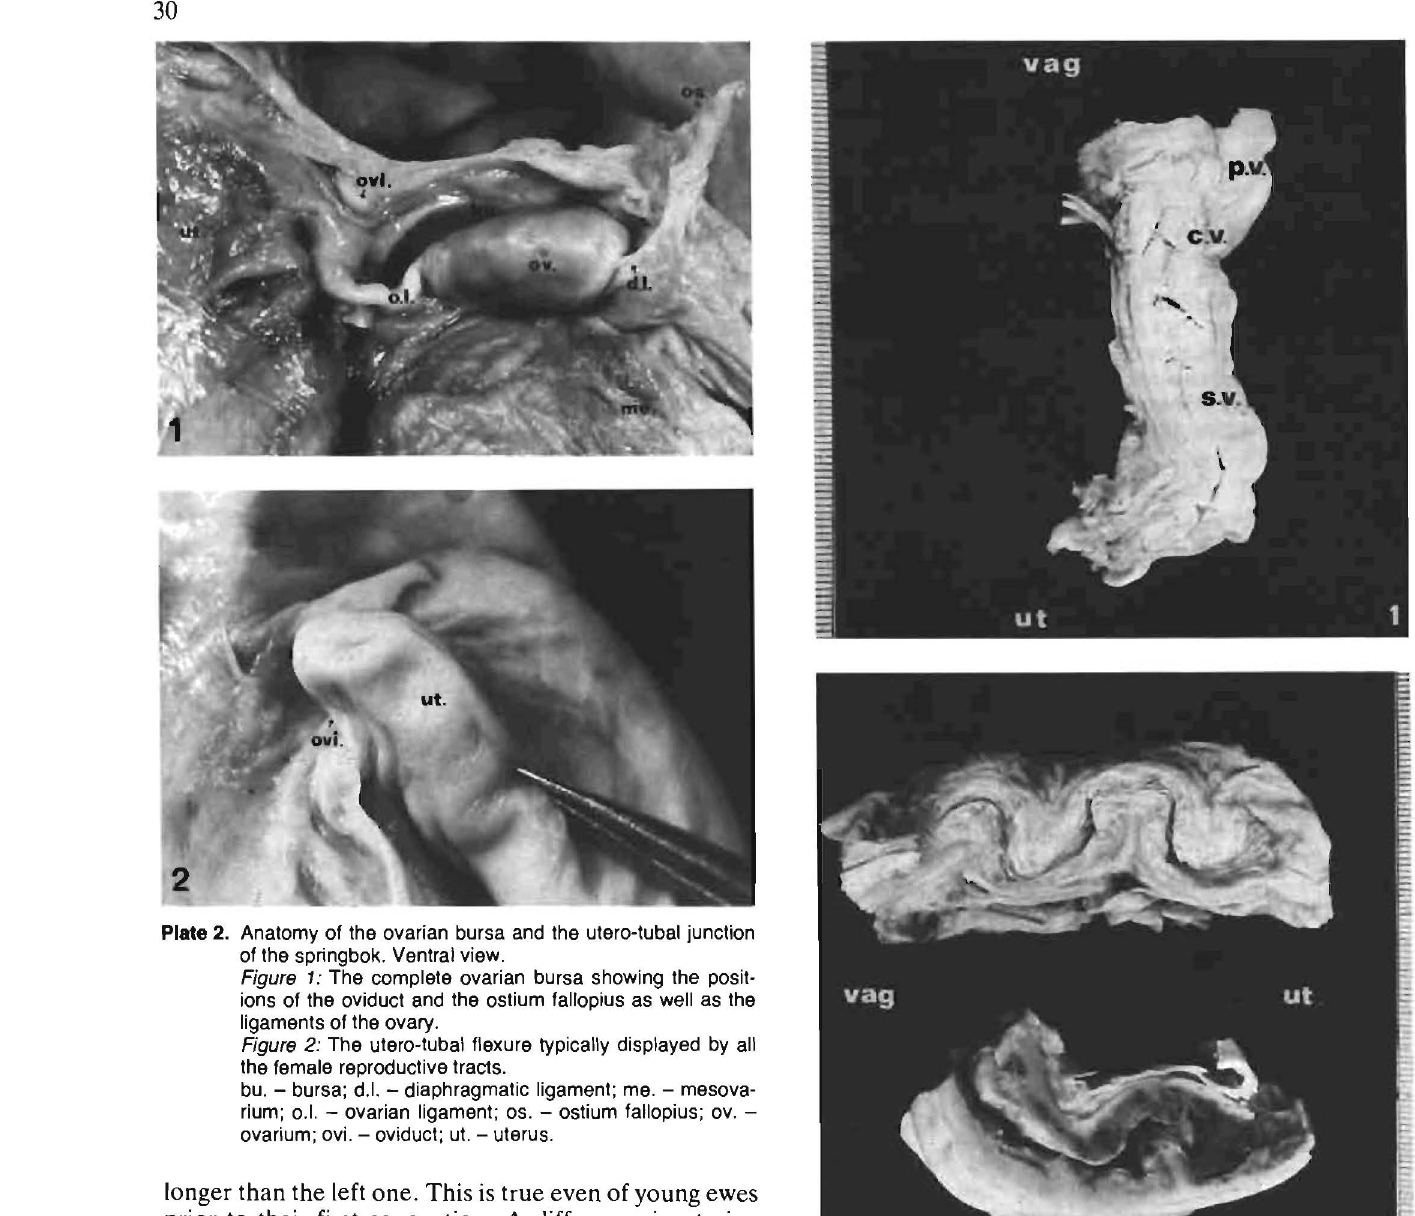
Plate 3. Anatomy of the cervix of the springbok. Figure 1: Cervix of a young non-pregnant ewe with four cupshaped proximal valves (c.v.) and one simple distal valve (s.v.). The positions of the portio vaginalis (p.v.), uterus (ut.) and vagina (vag.) are indicated. Figure 2: Cervices of pregnant ewes showing alteration in the position of the cervical lumen. The cervix at the bottom shows a typical haemorrhagic condition and the one at the top a very distinct alternation of the position of the cervical lumen. The positions of the uterus (ut.) and vagina (vag.) are